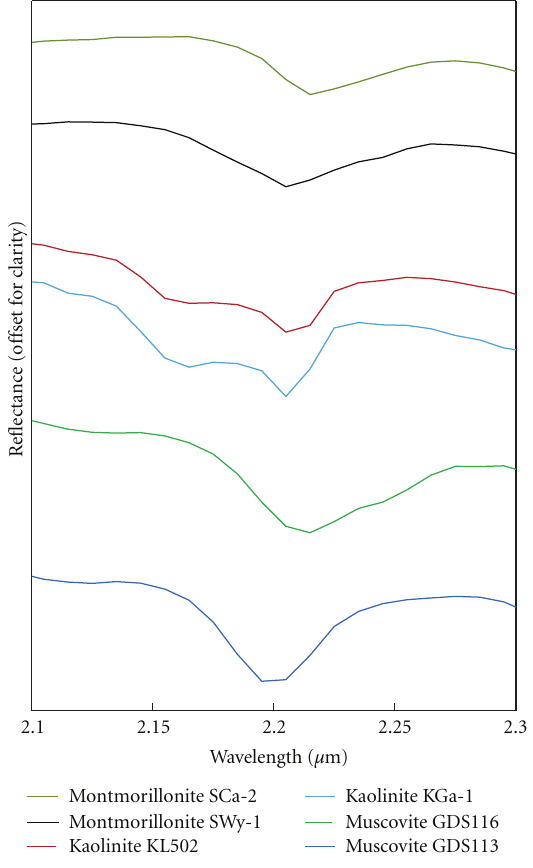
Figure 12: USGS VNIR-SWIR mineral library reflectance signa- tures for AlOH or clay phyllosilicate minerals highlighting the main 2.2 μ m absorption spectral feature [12].